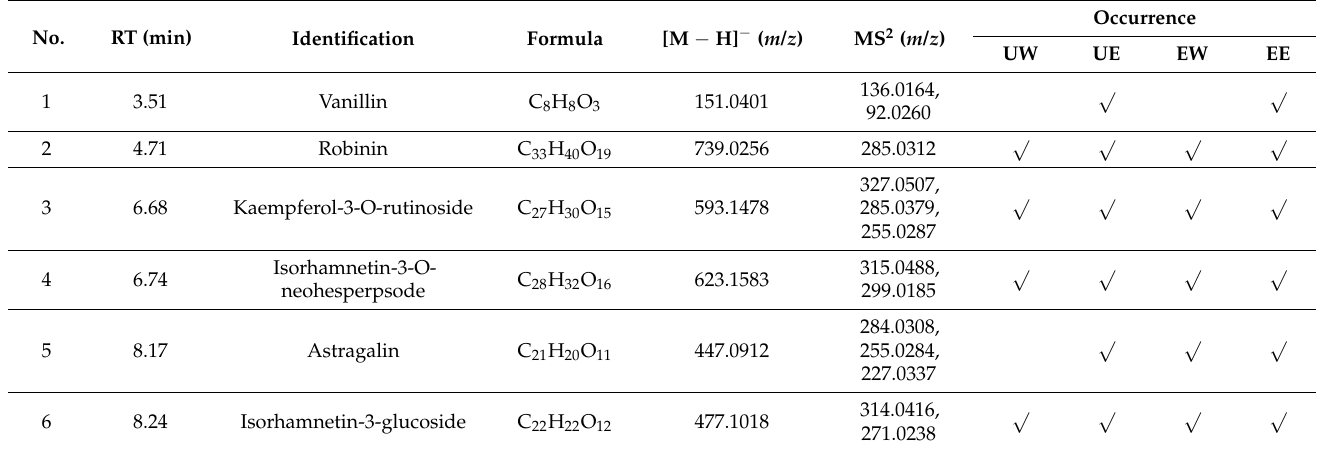
Table 1. Types of phenolic compounds identified using